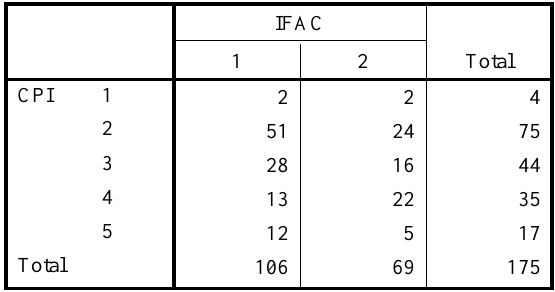
Table 6: 2 Test of the Relationship between the IFAC Code Application and